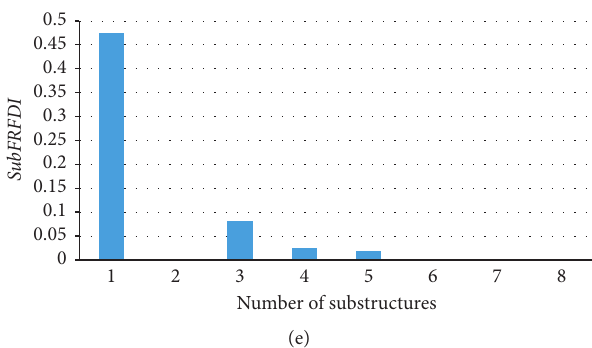
Figure 29: SubFRFDI values of LVDT-measured data for (a) case Dam50_1F&3F, (b) case Dam100_1F&3F, (c) case Dam200_1F&3F, (d)